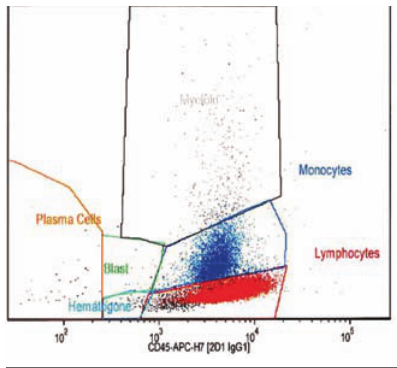
Figure 1. Open gated scattergram showing two distinct populations; one in the mono- cytic gate (blue) and the second in the lym- phocytic gate (red).